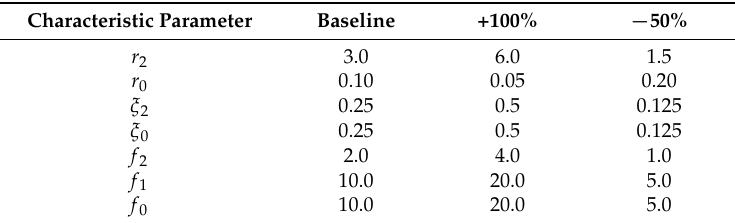
Table 6. The values of the characteristic parameters.